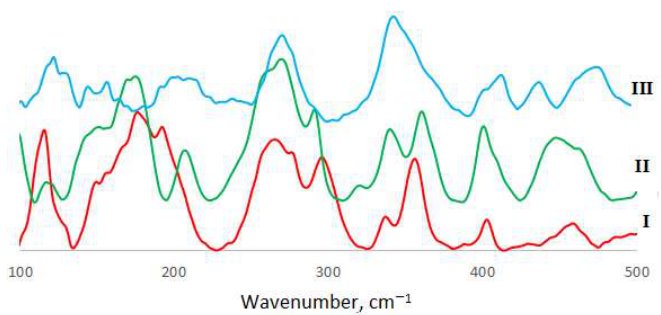
Figure 4. Far-IR spectra of o -phthalatocuprates.